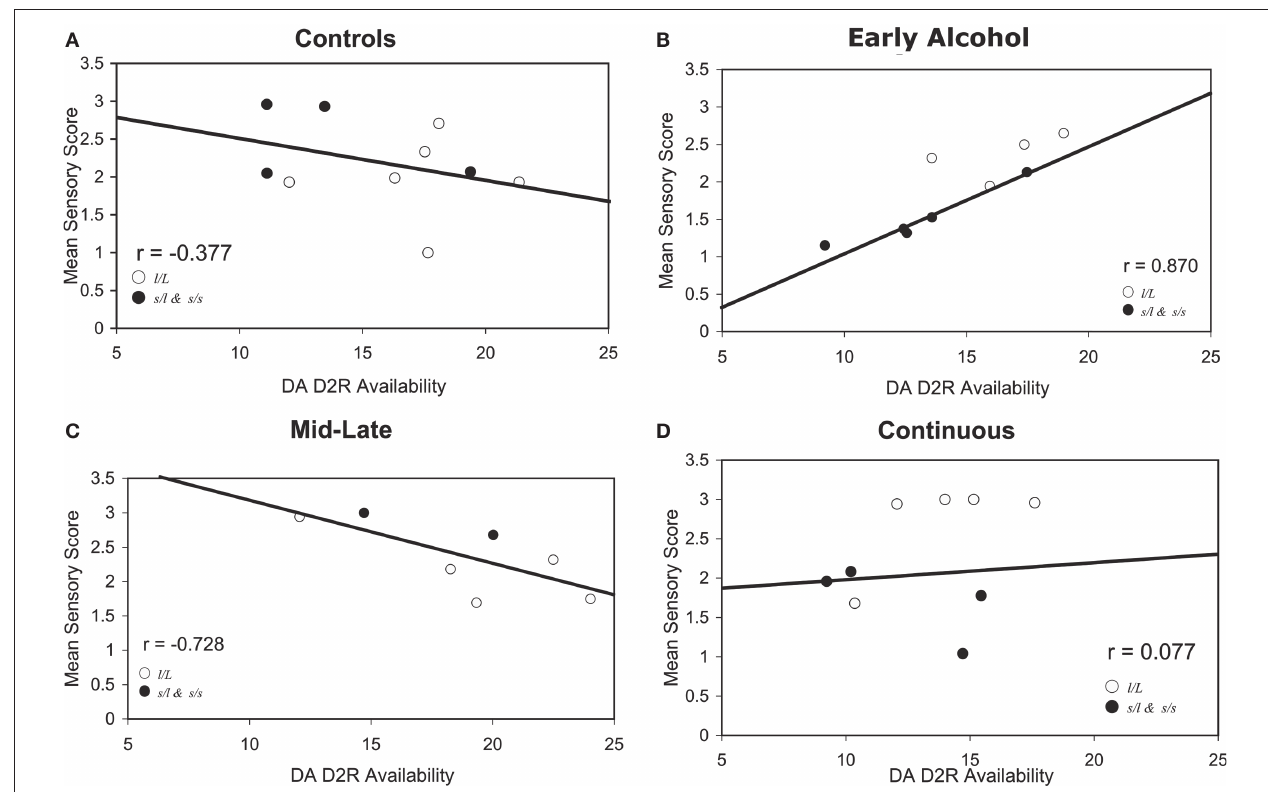
r = 0.87 p < 0.01 for (B) early gestation prenatal alcohol-exposed monkeys compared to r = − 0.728, p < 0.10 for (C) middle-to-late gestation exposed monkeys. Closed circles represent monkeys carrying the short (s) allele and open circles are monkeys with the l/l